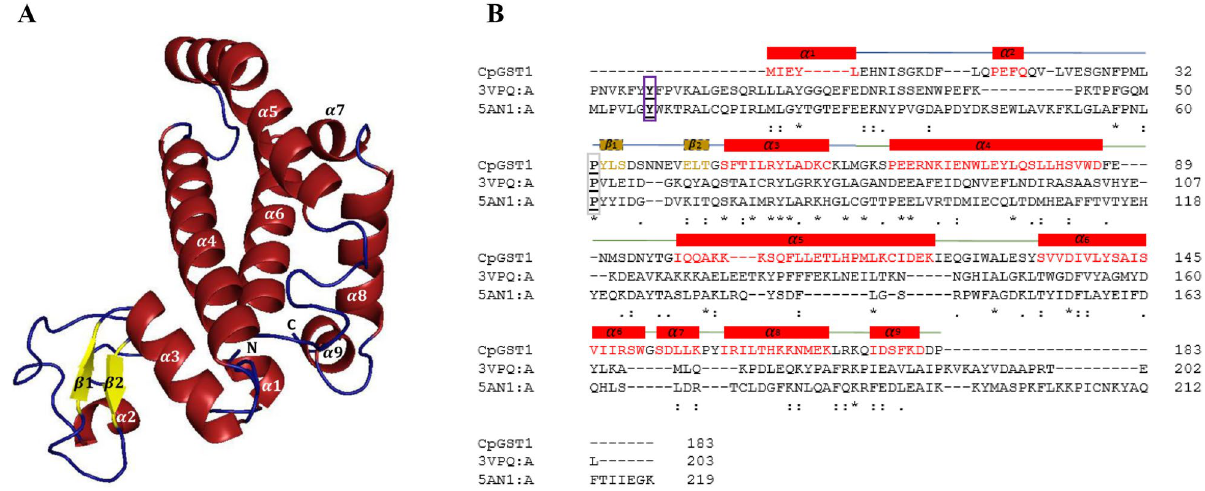
Figure 3. In silico structural analysis of Vega class representative Cryptosporidium parvum glutathione transferase 1 (C p GST1). 3D model of C p GST1 ( A ) and its amino acid sequence alignment with templates ( B ). Secondary structural annotations were done as per modeled structure where α-helices and corresponding amino acids are colored in red while the β-sheets and their corresponding amino acids are colored in yellow. The active-site tyrosine and the cis -proline residues are boxed in purple and grey respectively. The template Protein Data Bank codes, 3VPQ-A and 5AN1-A, represents GST protein crystal structures from Bombyx mori (Sigma class GST) and Penaeus vannamei (Mu class GST).